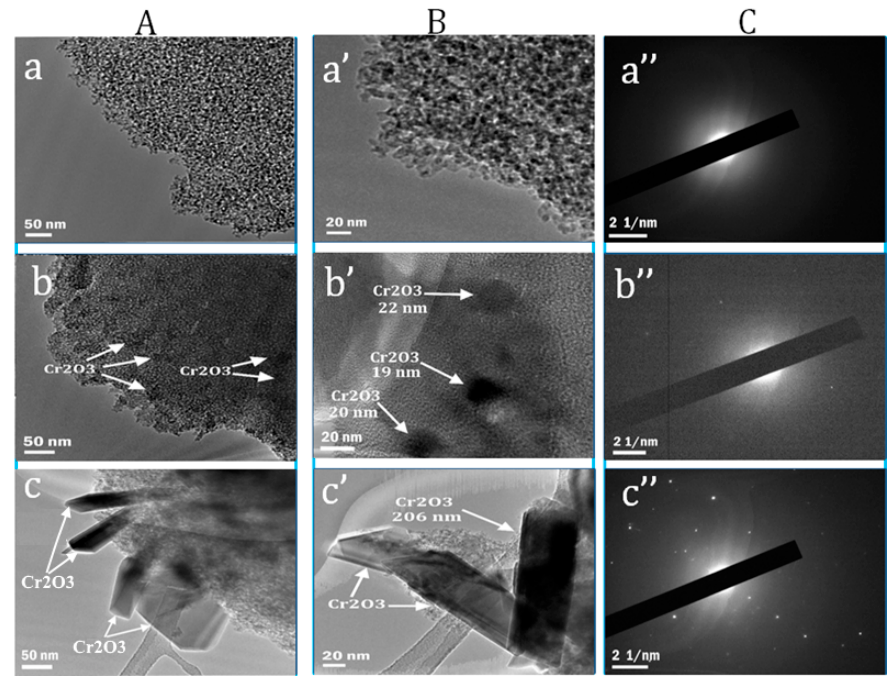
Figure 4. ( A ) Low-magnification TEM images of Cr(y)/LPMS-130 with different chromium loadings: y = ( a ) 0, ( b ) 4, and ( c ) 8. ( B ) High-magnification images of Cr(y)/LPMS-130 with different chromium loadings: y = ( a’ ) 0, ( b’ ) 4, and ( c’ ) 11. ( C ) SAED images of Cr(y) / LPMS-130 with di ff erent chromium loadings: y = ( a” ) 0, ( b” ) 4, and ( c” )